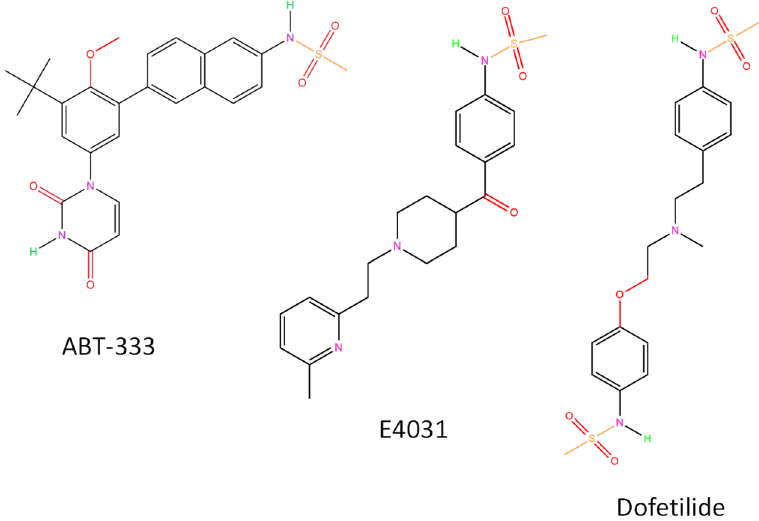
Figure 1. Chemical structures of ABT-333 and two I Kr blockers. All structures were created by ChemDrawPro 12.0 software.